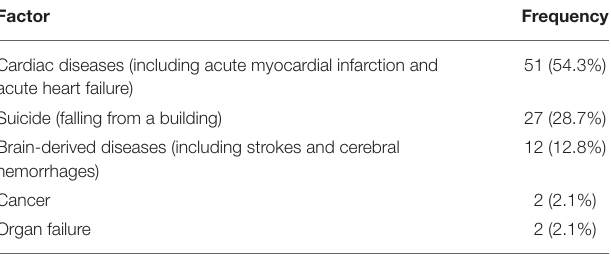
TABLE 2 | Direct causes of death in overwork death cases among physicians. Factor